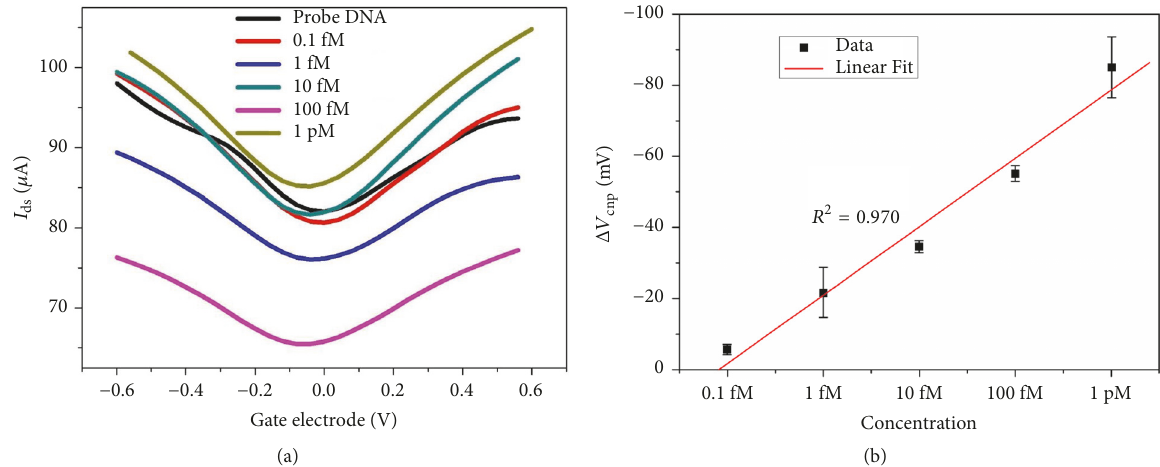
Figure 4: (a) Transfer characteristics of G-FET with addition of different concentrations of target RNA from 0.1fM to 1pM. (b) The change of Δ𝑉 of the G-FET with addition of the target RNA from 0.1 fM to 1pM. cnp